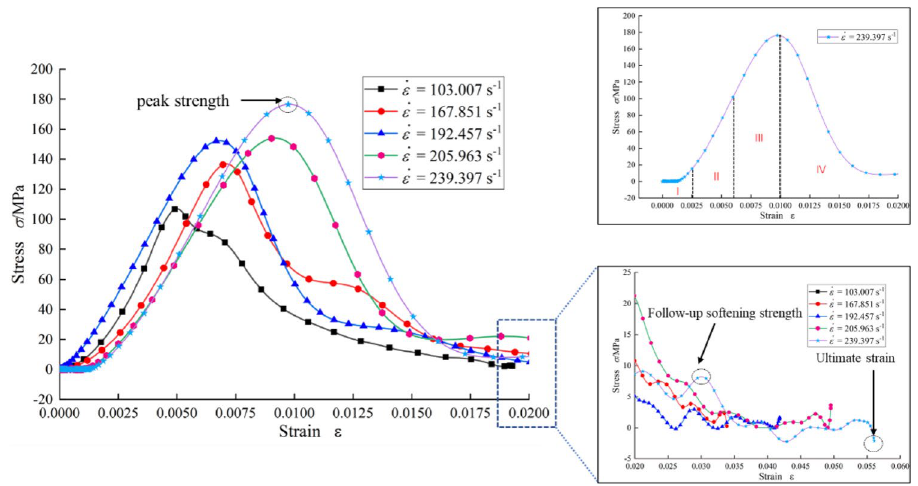
Figure 4. Typical stress–strain curves of graphite ore rock samples at different strain